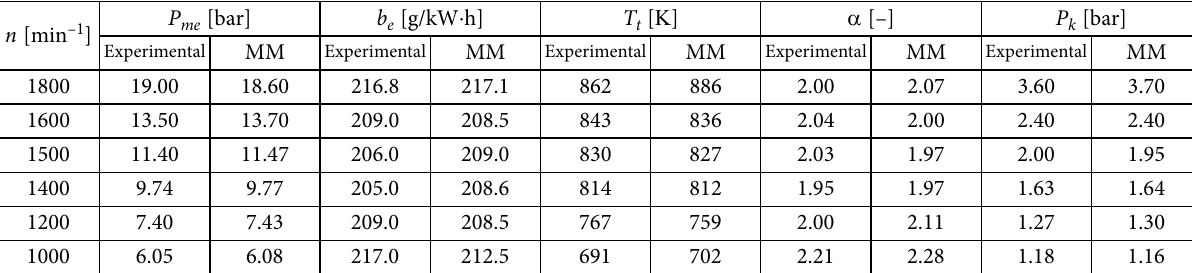
Table A1. Comparison of diesel engine Caterpillar 3512B MM adequacy validation experiment and modelling results